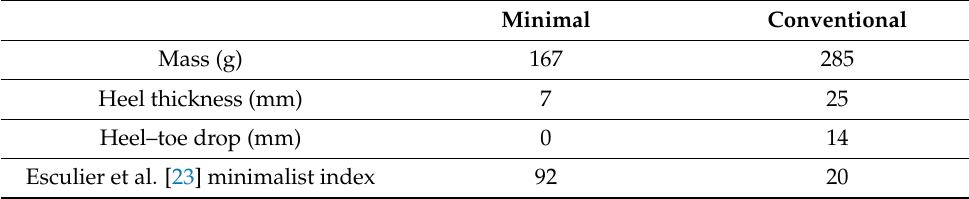
Table 1. Experimental footwear